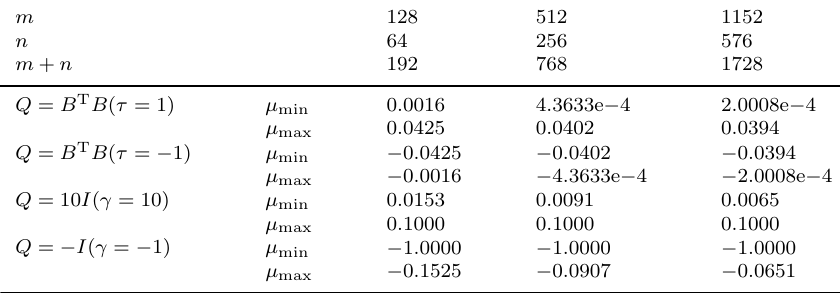
Table 1. The minimum μ min and the maximum μ max eigenvalue of Q − 1 B T A − 1 B . m 128 512 1152 n 64 256 576 m + n 192 768 1728 Q = B T B ( τ = 1) μ min 0.0016 4.3633e − 4